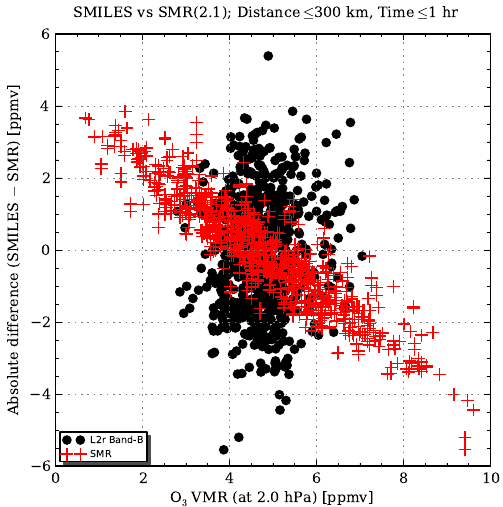
Fig. 21. Measured O 3 abundances of SMILES and SMR, and corresponding absolute differences. Only Band-B data for SMILES is shown. Y.Kasaietal.: SMILES O 3 validation(NICTL2-v215)